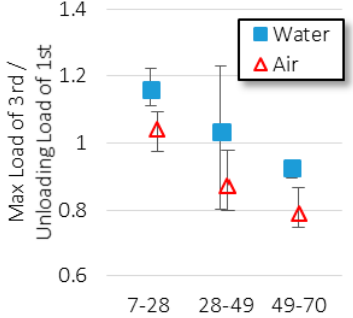
Figure 11. Ratios between the maximum load of the 3rd loading and the unloading load of the 1st loading (different crack inducement times).